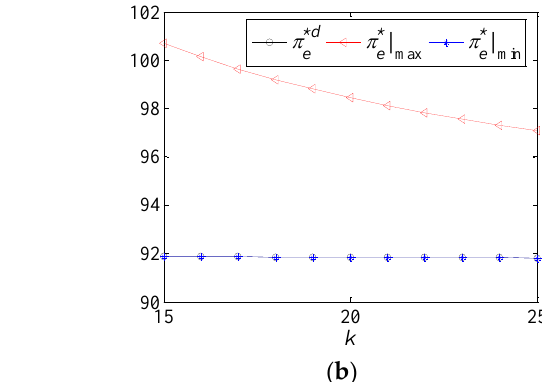
∗ m ; ( b ) Coordination results of π